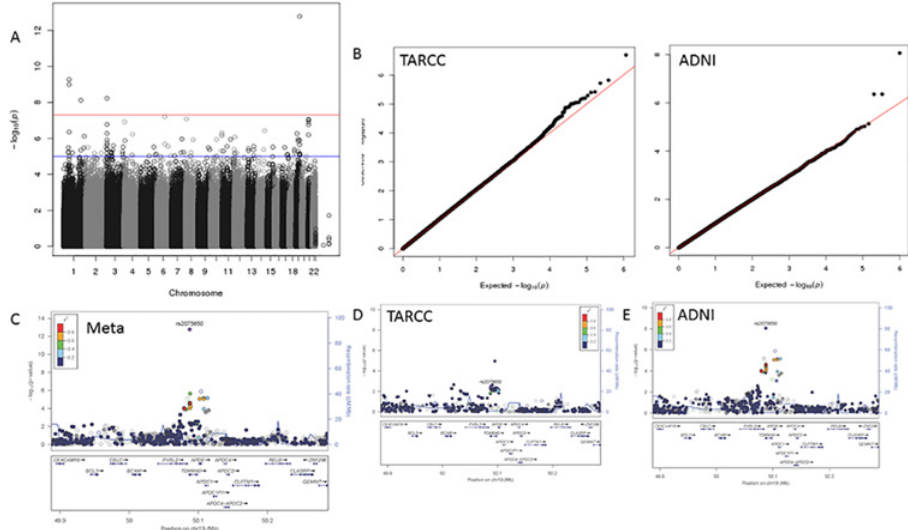
Fig 5. Case Control results. Panel A; GWAS Manhattan plot for Case Control status. Panel B; QQ plots for the association results for TARCC (left) and ADNI (right). Panel C; LocusZoom plot for the chromosome 19 signal from the meta-analysis. Panels D and E; LocusZoom plots for the chromosome 19 signal in TARCC and ADNI, respectively.